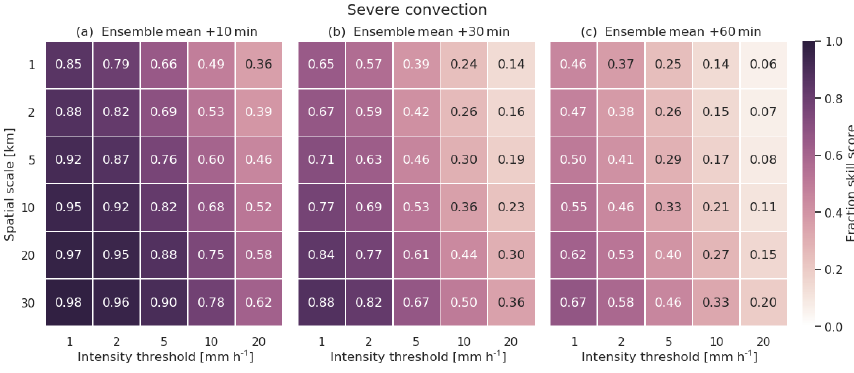
Figure 23. Same as Fig. 22 but for the severe convection case study (event no. 2 in Table